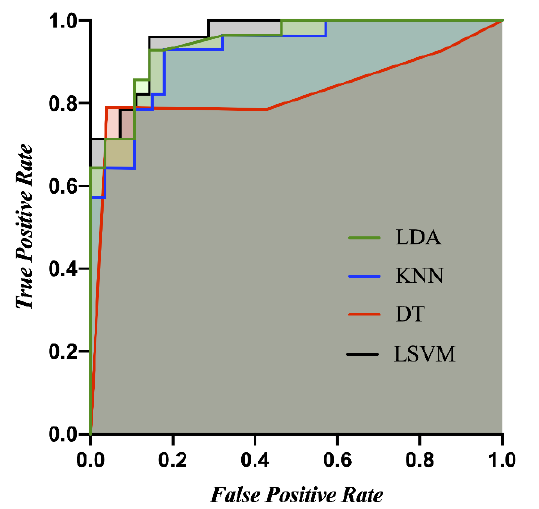
Figure 7. ROC curves for 10-fold cross validation according to the four classifiers (LDA, KNN, DT, and LSVM).